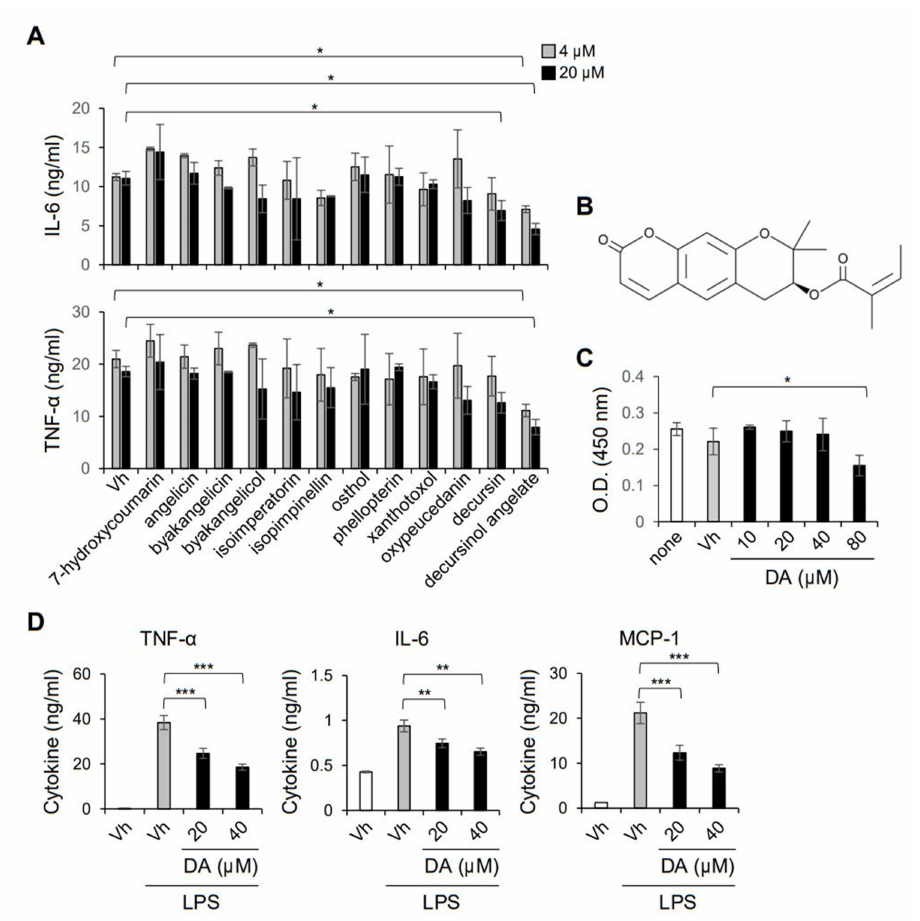
Figure 2. DA suppresses LPS induction of pro-inflammatory cytokines in macrophages. ( A ) Peritoneal macrophages were pretreated with the indicated compounds of A. gigas and activated with 200 ng/mL LPS for 8 h. Production of IL-6 and TNF- α in the culture supernatant was measured by CBA; n = 4. ( B ) Chemical structure of DA. ( C ) BMDMs were incubated in the presence of the indicated concentrations of DA for 24 h, and cell viability was assessed. ( D ) RAW 264.7 cells were pretreated with DA and incubated in the presence of LPS for 8 h. LPS induction of TNF- α , IL-6, and MCP-1 was determined by CBA and shown as the mean ( ± S.D.) concentration of the indicated cytokines; n = 4; * p < 0.05, ** p < 0.01, *** p <